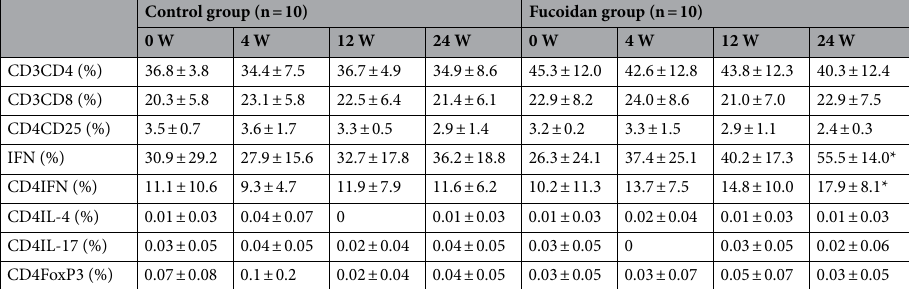
Table 3. The proportion of immune cell types in the two groups during supplementation period. *: Indicates that there is a significant difference between the 4thweek, the 12thweek, the 24thweek and the 0thweek of the fucoidan group ( p < 0.05).